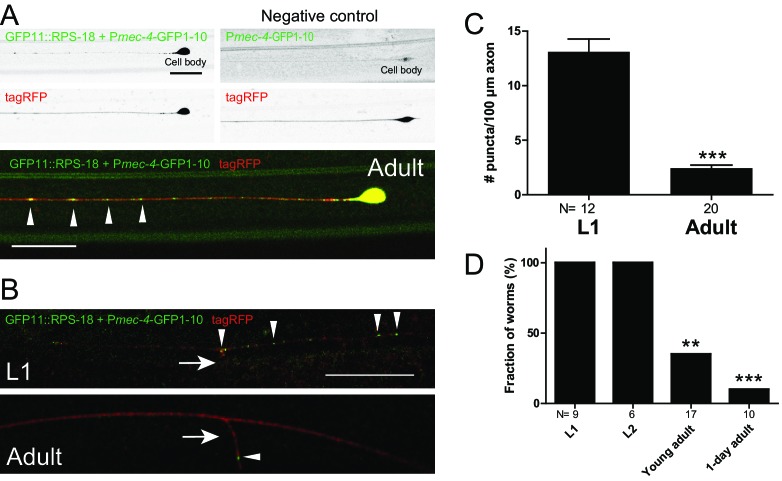
Ribosomes form puncta along the sensory neuron axons.Mechanosensory neuron-specific Pmec-4-RIBOS (juSi94[GFP11::rps-18] juIs438[Pmec-4-GFP1−10+Pmec-4-tagRFP]; rps-18(0)). (A) ALM neurons at the adult stage. Negative control strain expressing only GFP1-10 had weak signals in the nucleus. Ribosomes form puncta along the ALM axon (arrowheads). Scale bars: 20 µm. (B) Comparison of RIBOS signals between L1 and adult stages around the synaptic branch of PLM neurons. Arrows and arrowheads indicate synaptic branches and RIBOS signals, respectively. Scale bar: 20 µm. (C) Number of puncta per 100 µm axon around the PLM branch. Statistics: Student’s t-test, ***p<0.001. N: number of worms. (D) Fraction of worms with ribosomes associated with PLM branch point at indicated developmental stages. Statistics: Fisher’s exact test, compared to the L1 stage. **p<0.01, ***p<0.001. N: number of worms.